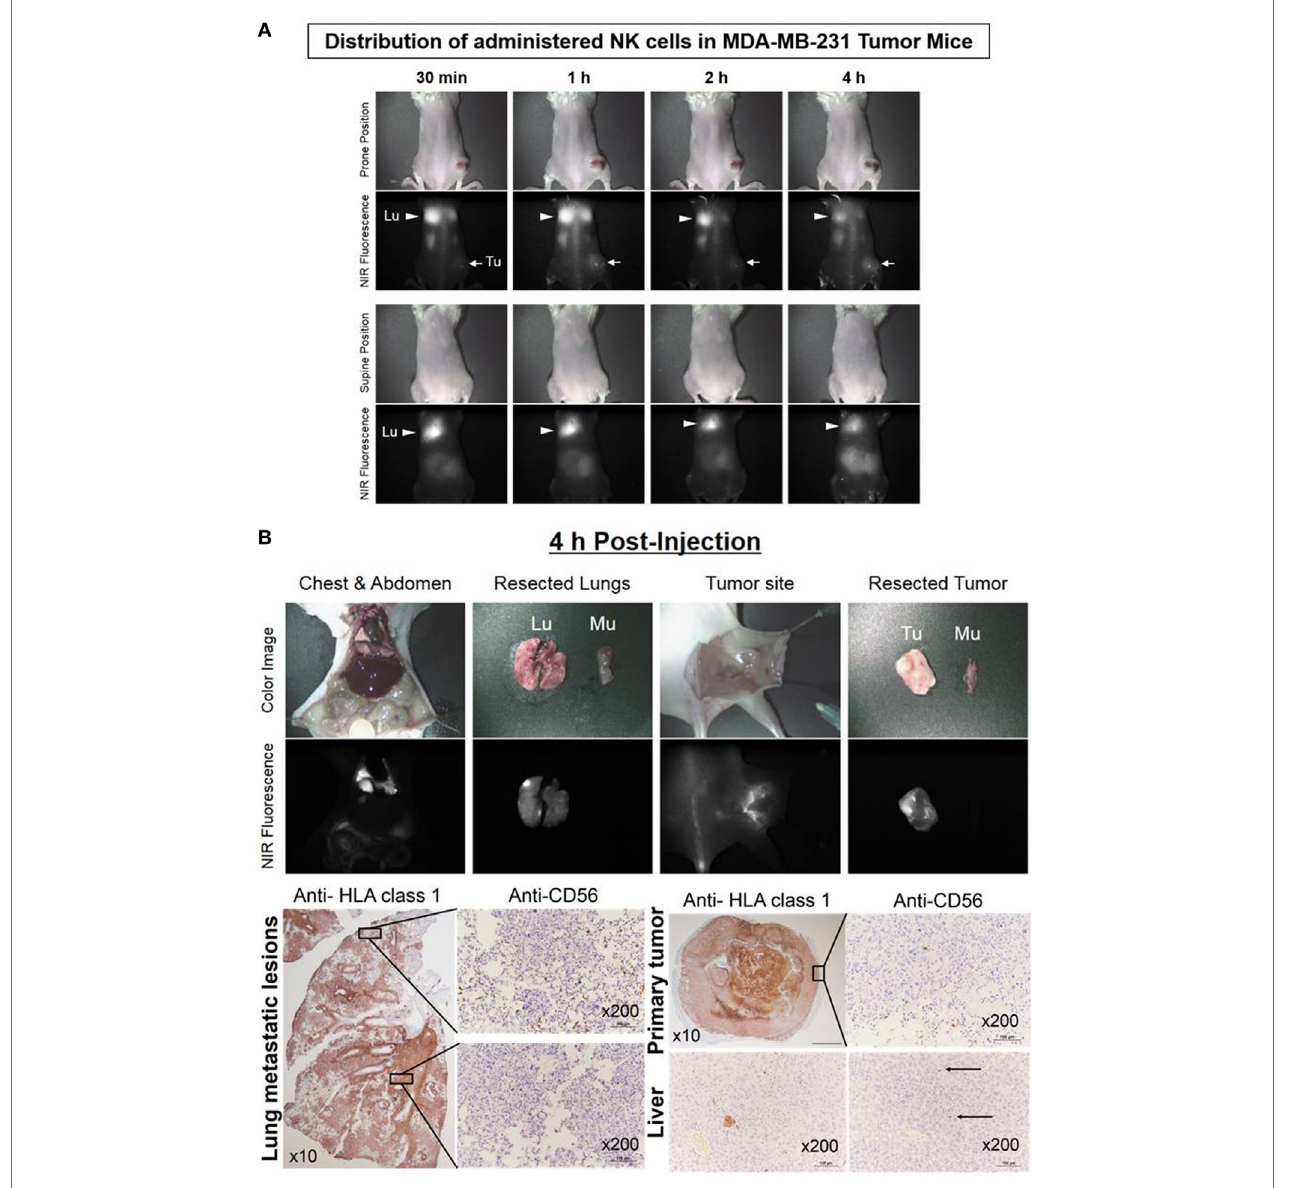
FigUre 6 | Real-time trafficking of natural killer (NK) cells in a human breast cancer xenograft model. Expanded NK cells were stained with 0.2 µM of ESNF13 and intravenously injected into MDA-MB-231 tumor-bearing NSG mice after 44 days tumor inoculation. (a) The fluorescent signal was detected using a near-infrared (NIR) fluorescent system. After 4 h, the mice were sacrificed and resected organs were explored. (B) The lung, liver, and tumor were resected 4 h after injection of ESNF13-stained NK cells and were stained with anti-HLA or anti-CD56 to detect the tumor and infiltrative CD56 + NK cells. The tumor cells were highlighted with HLA class 1 antibody and the localization of the NK cells corresponding to the scan imaging was demonstrated with CD56 immunohistochemistry. The lung showed a higher population of NK cells at the apex and the tumor specimen displayed an NK cell population mainly at the tumor margin. In accordance with fluorescence signal below detection limit, the liver had only micrometastatic tumors and few CD56 + NK